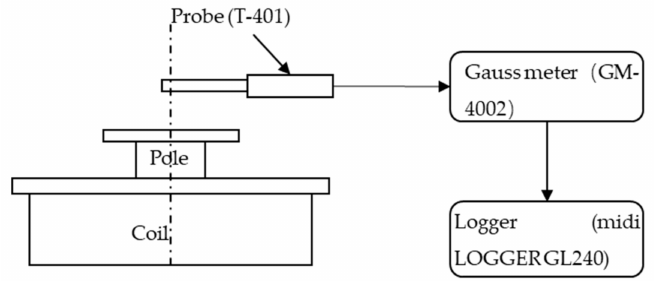
Figure 3. Magnetic flux density measurement.